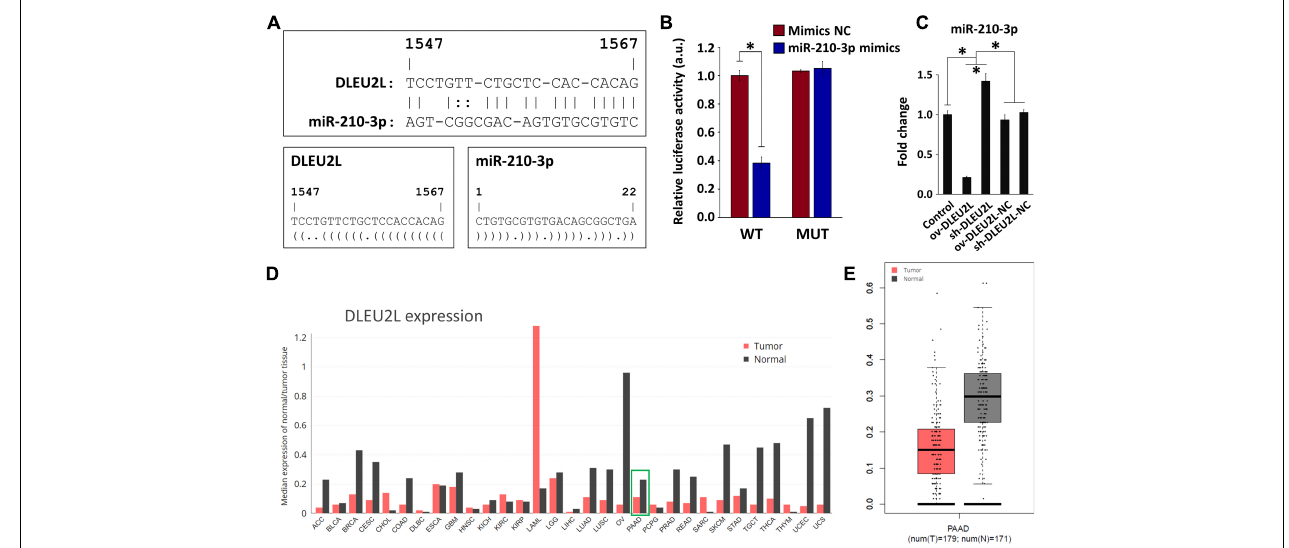
FIGURE 1 | Targeting relationship between DLEU2L and miR-210-3p and expression of miR-210-3p in pancreatic cancer. (A) Binding sites between DLEU2L (from position 1,547) and miR-210-3p, predicted by RNA22. Dot-bracket notation illustrates binding at specific nucleotides. (B) Dual luciferase activity assay of binding relationship between DLEU2L and miR-210-3p, using miR-210-3p mimics or negative control (NC). Relative luciferase activity represents the ratio of firefly luciferase to renilla luciferase. (C) qRT-PCR of the expression of miR-210-3p in PANC-1 cells that were transfected with DLEU2L overexpression (ov-DLEU2L) or interference (sh-DLEU2L) vectors (or their respective negative control/NC). (D) Median expression of DLEU2L in various types of tumor tissues compared to that in adjacent normal tissues in clinical samples. The plot was generated using data from the GEPIA web site. (E) Relative expression of DLEU2L in PAAD tumor samples and adjacent normal tissue samples. The plot was generated using data from the GEPIA web site. PAAD, pancreatic adenocarcinoma. Numerical data in (B,C) are expressed as the mean ± SD ( n = 3); ∗ p < 0.05. Statistical analysis was carried out using